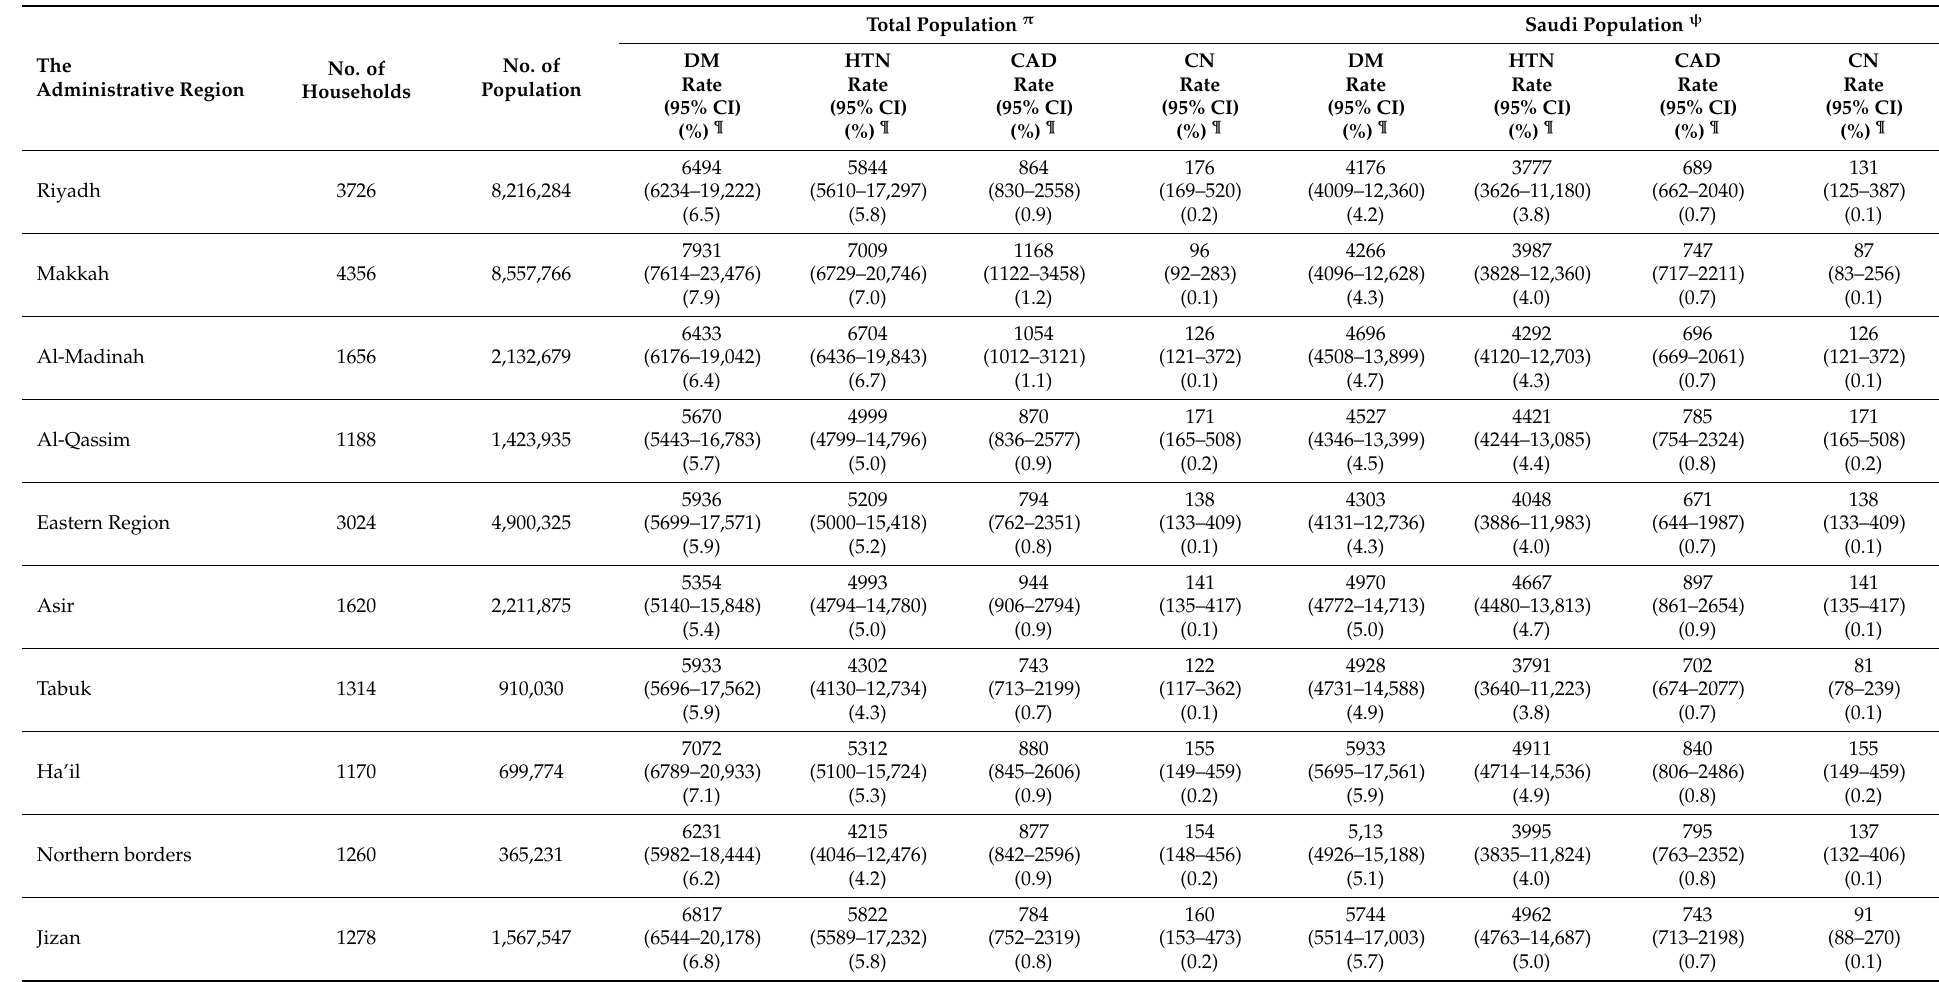
Table 1. The rates of chronic diseases per 100,000 population-year in total and Saudi populations by the administrative